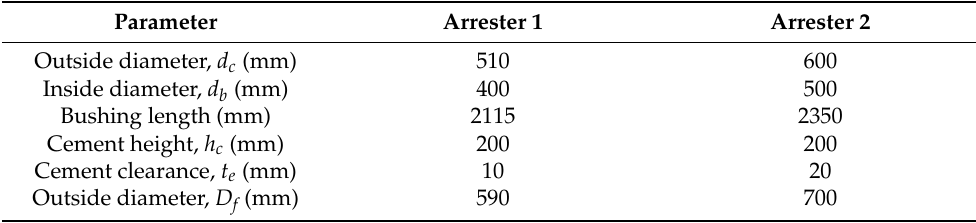
Figure 9. Ultra-high voltage lightning arresters. Table 5. Geometric parameters of typical ultra-high voltage electrical